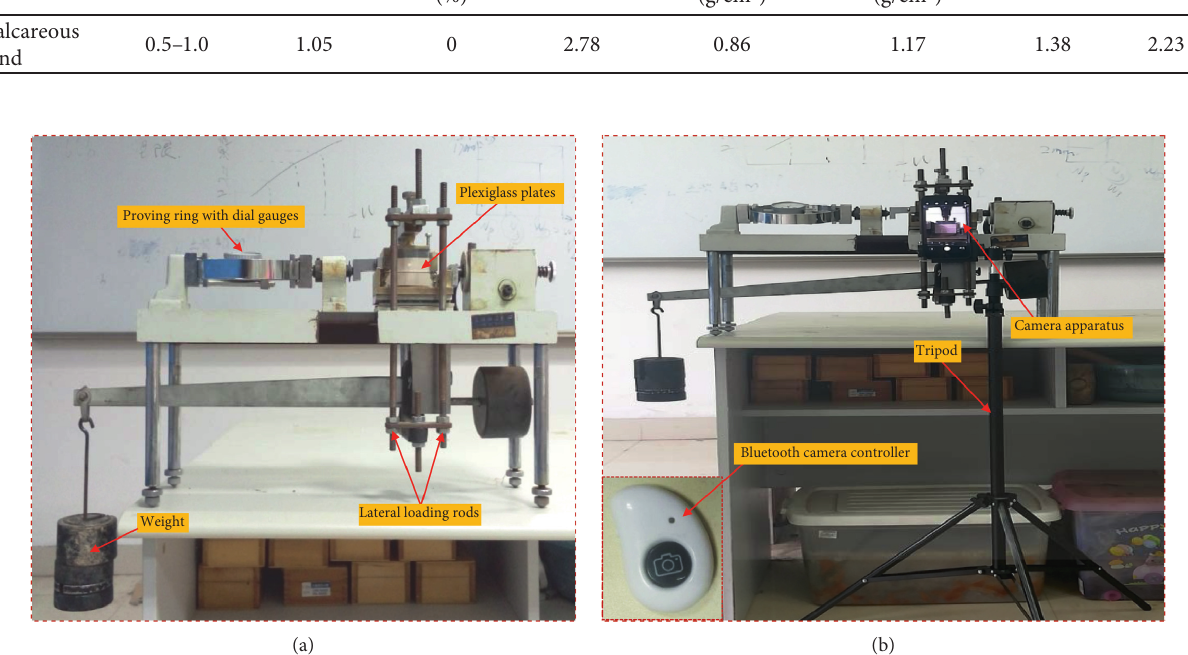
Figure 2: Test equipment. (a) A half-mold direct shear apparatus; (b) the image acquisition system.